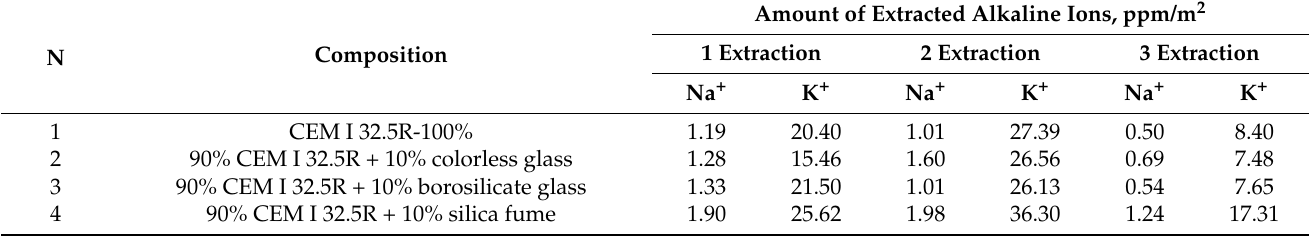
Table 6. The effect of the extraction number on the amount of extracted alkaline ions. Amount of Extracted Alkaline Ions, ppm/m 2 1 Extraction 2 N Composition